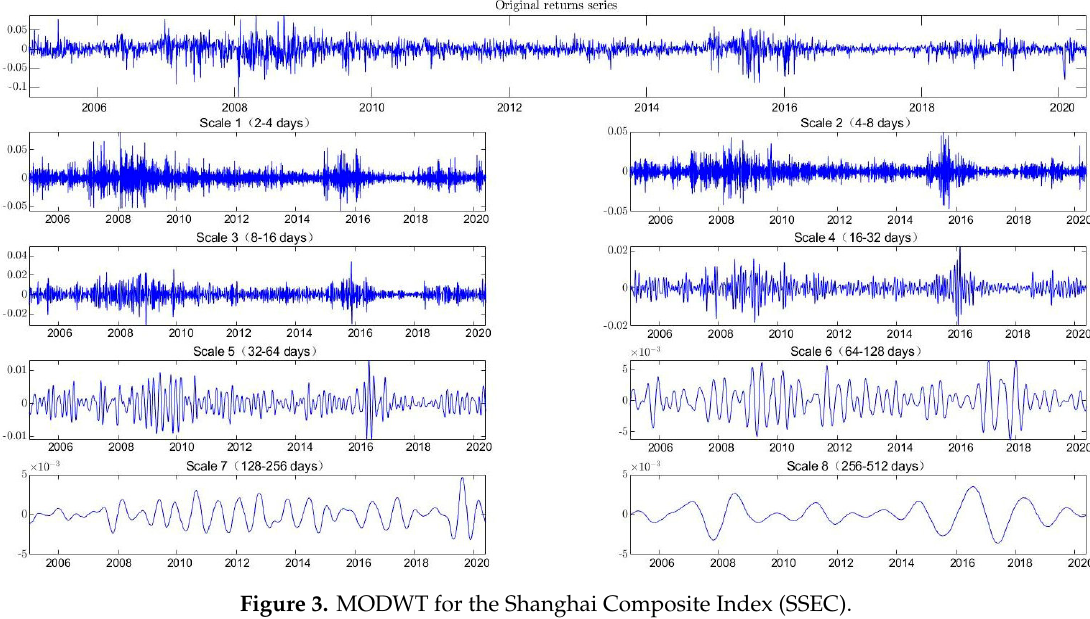
Figure 2. Maximum overlapping discrete wavelet transformation (MODWT) for Brent spot price.